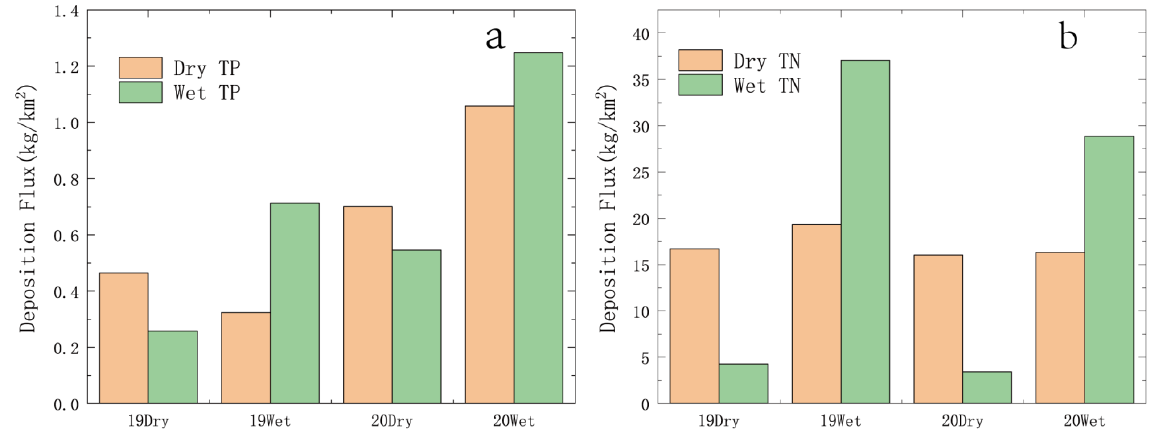
Figure 3. Atmospheric nitrogen and phosphorus deposition fluxes in dry and wet seasons. ( a ) Dry and Wet TP deposition; ( b ) Dry and Wet TN deposition. Table 2. Physical and chemical characteristics of water quality in different locations of the MRP in Henan